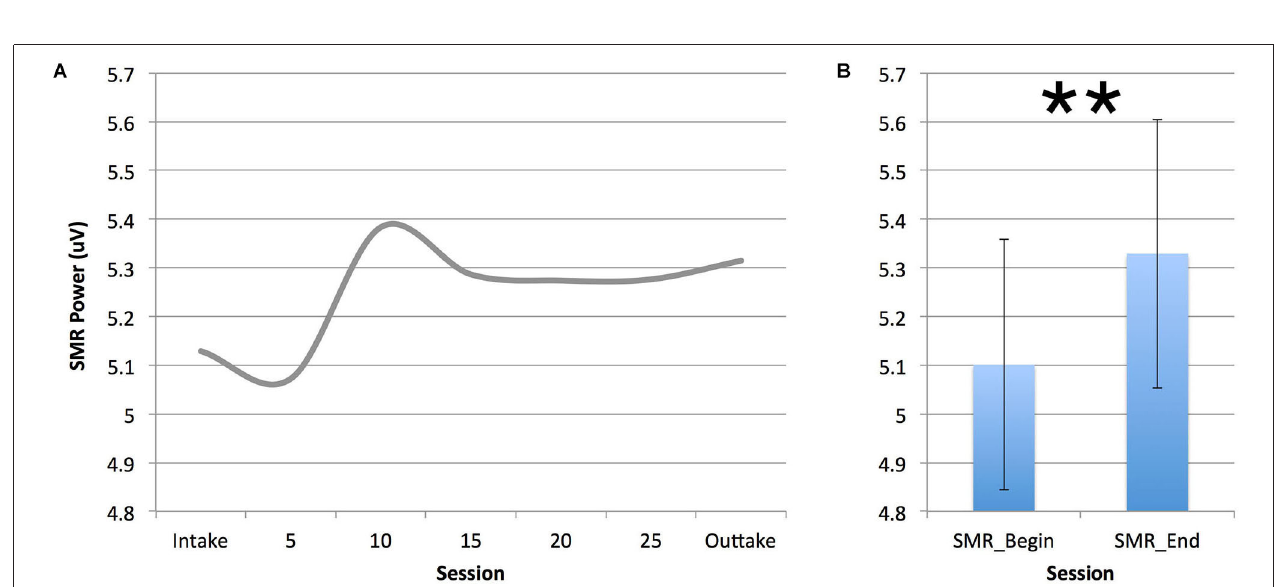
FIGURE 4 | Correlation between the change in ADHD-RS inattention and change in PSQI (A) and change in SOL (B) . Note that only for the SMR treated group a significant association between